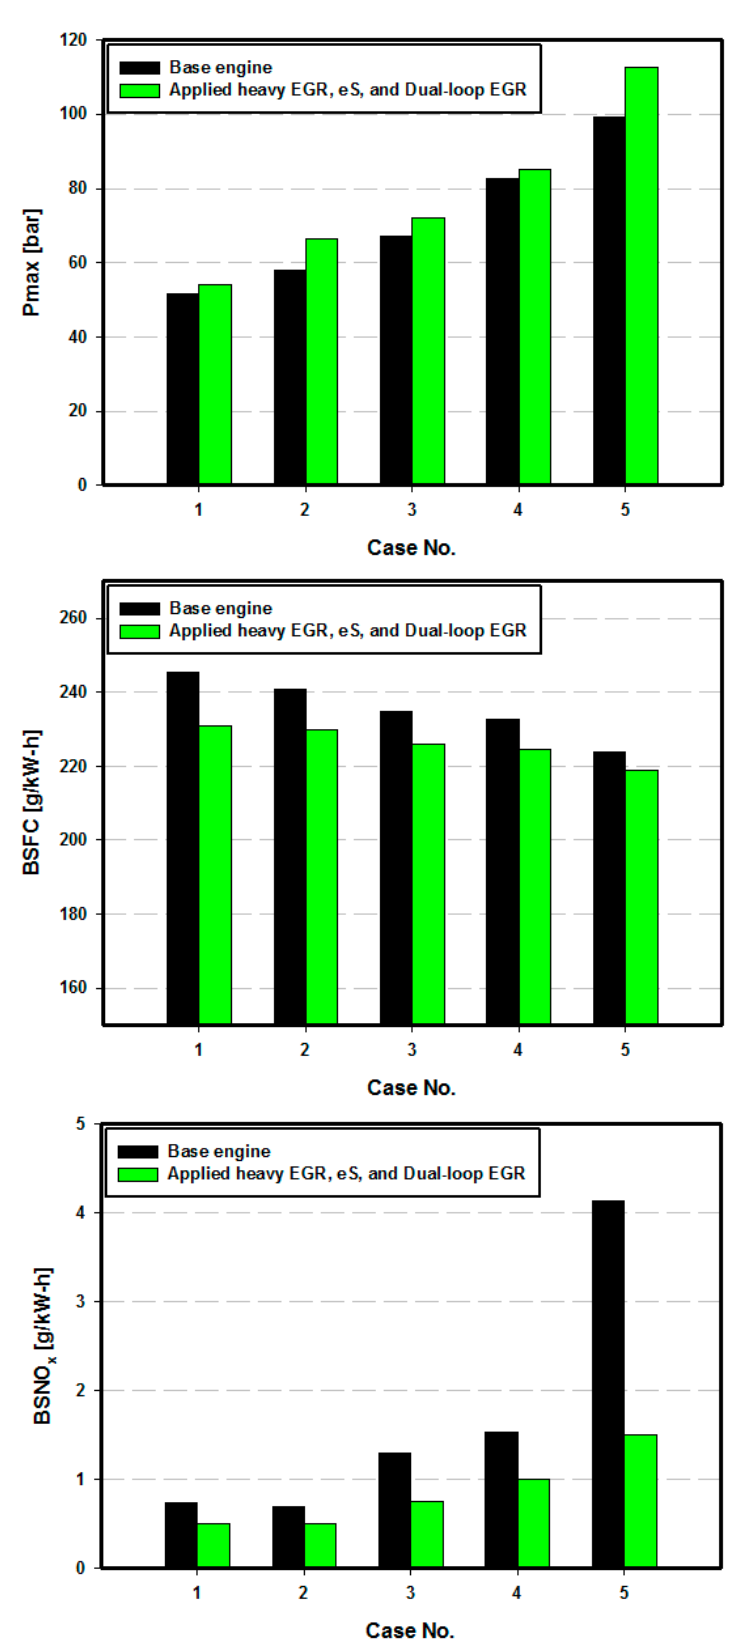
Figure 21. Comparison of base engine and optimized engine with respect to Pmax, BSFC, and BSNO x .